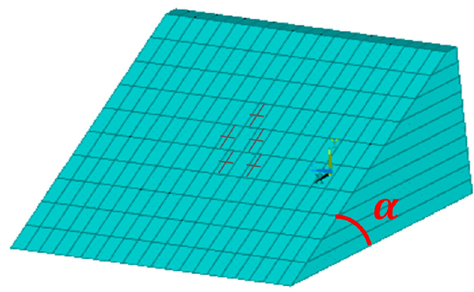
Figure 9. Inclined dam face in rectangular valley.